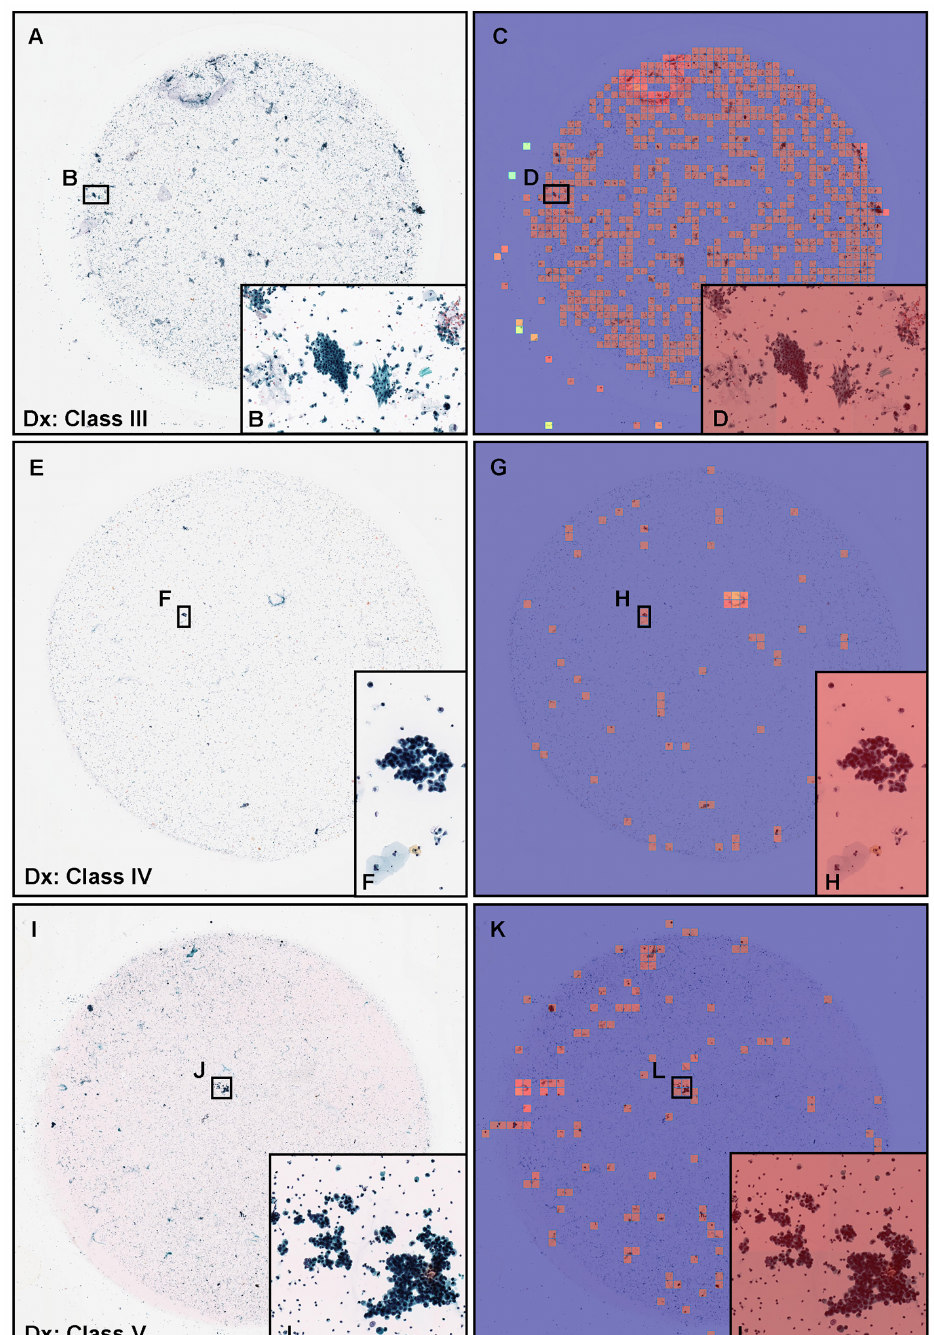
Figure 5. Representative examples of true positive prediction. Neoplastic true positive prediction outputs on urine liquid-based cytology (LBC) whole-slide images (WSIs) from test sets using the ENB1-UC-FS+WS model. According to the cytopathological diagnostic (Dx) reports, ( A ) was diag- nosed as Class III with atypical urothelial epithelial cells ( B ), ( E ) was diagnosed as Class IV with suspected low grade urothelial carcinoma (LGUC) cells ( F ), and ( I ) was diagnosed as Class V with suspected high grade utorhelial carcinoma (HGUC) cells ( J ). The heatmap images ( C , D , G , H , K , L ) show true positive predictions of neoplastic urothelial epithelial cells ( D , H , L ), which correspond, respectively, to atypical ( B ), suspected LGUC ( F ), and HGUC ( J ) cells. The heatmap uses the jet color map where blue indicates low probability and red indicates high